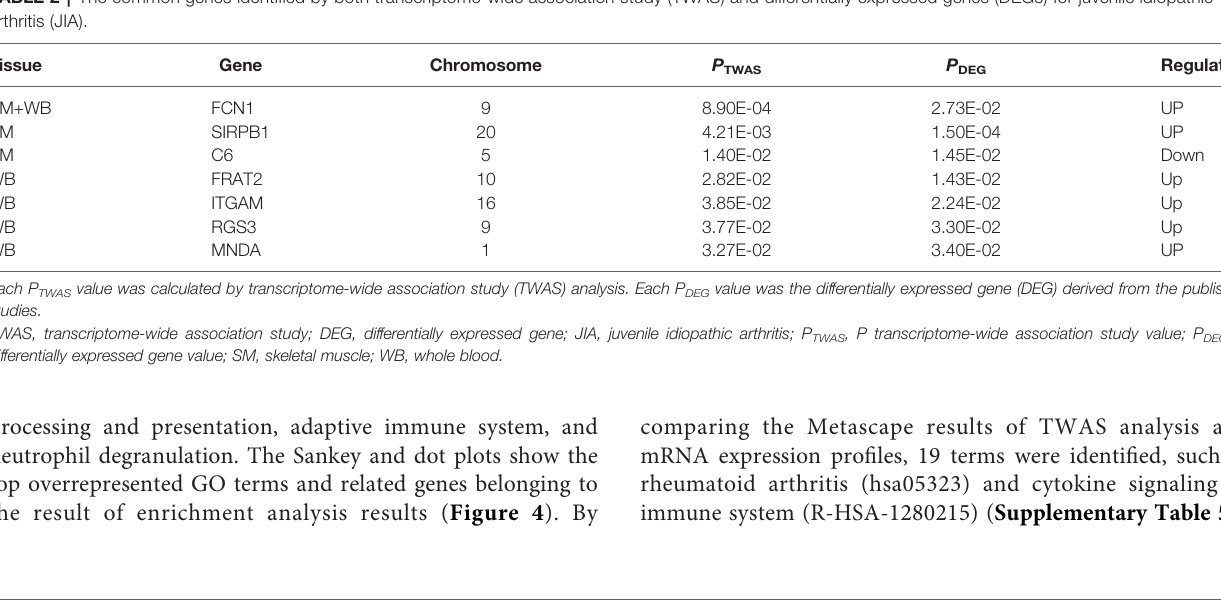
TABLE 2 | The common genes identi fi ed by both transcriptome-wide association study (TWAS) and differentially expressed genes (DEGs) for juvenile idiopathic arthritis (JIA). Tissue Gene Chromosome P